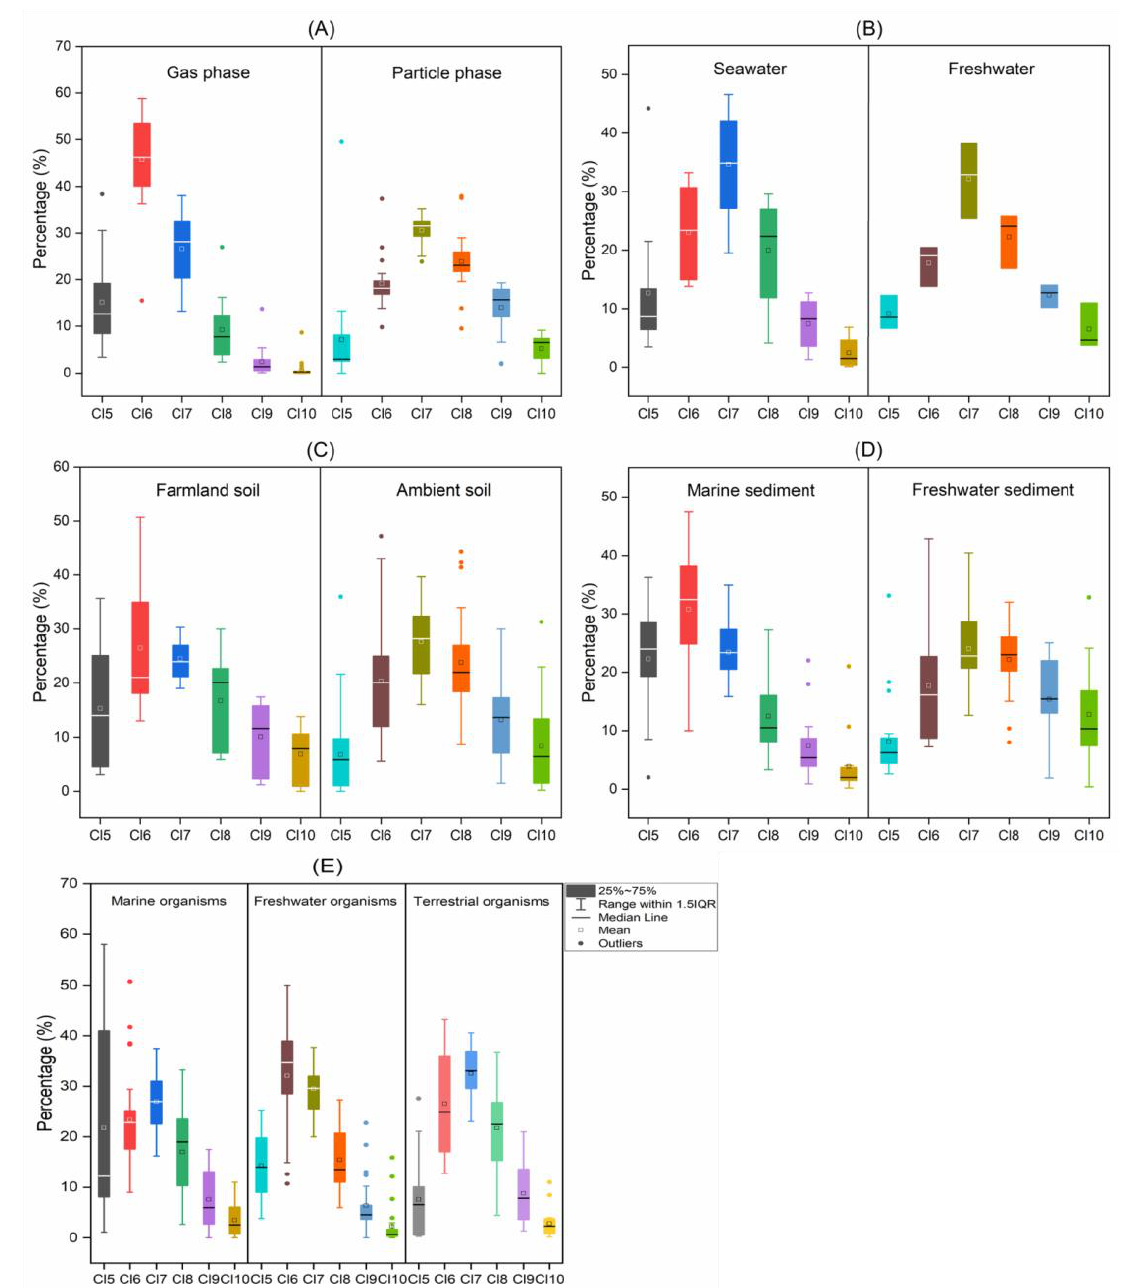
Figure 4. Chlorine profiles of SCCPs in different environmental matrices in China. ( A ) Chlorine profiles of SCCPs in air. ( B ) Chlorine profiles of SCCPs in water. ( C ) Chlorine profiles of SCCPs in soil. ( D ) Chlorine profiles of SCCPs in sediment. ( E ) Chlorine profiles of SCCPs in biota. SCCP profiles in different soils were listed in Table S9. Similar carbon profiles were found in farmland and ambient soils, and C 10 congeners were dominant in both types of soils, contributing to 33.9% and 32.5%, respectively (Figure 3C). Cl 6 congeners (26.5%) were the most abundant groups in farmland soil and Cl 7 (27.6%) was the largest group of chlorine homologues in ambient soil (Figure 4C). This difference was mainly due to the sources of SCCPs in soils. Consistent with SCCP congeners in the atmosphere, we found that C 10 (53.1%) accounted for the highest proportion in the background area (Figure S4C), indicating that atmospheric transport and deposition was the main source of SCCPs in the background area. However, in contrast to the carbon profiles, the chlorine